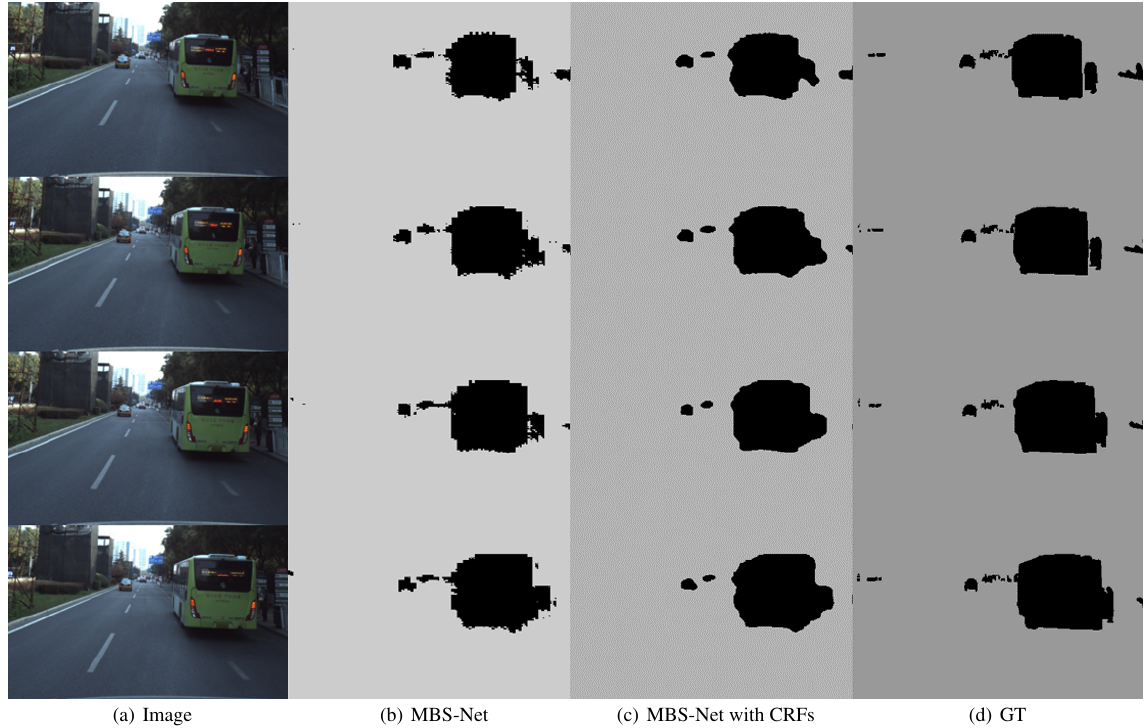
Figure 4. MBS-Net example results (a) is original input sequential images. (b) is sequential MBS-Net output masks without activating CRFs (c) is sequential output masks with CRFs (d) is Ground